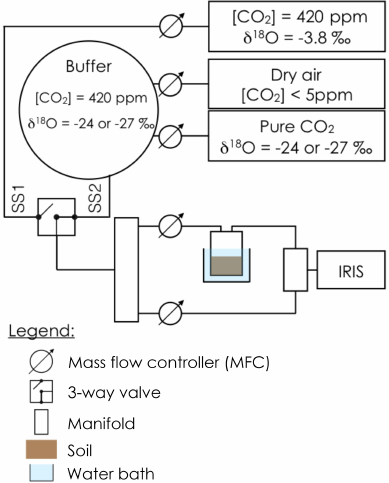
Figure 1. Schematic of the experimental setup used to estimate si- multaneously the CO 2 –H 2 O isotope exchange rate ( k iso ) in a soil microcosm and the oxygen isotopic composition of the soil water pool with which the CO 2 equilibrates ( δ sw-eq ) . The soil microcosm consists of 280–300g of dry soil previously re-humidified to 25% of the water holding capacity using mineral water containing differ- ent amounts of exogenous CA powder. The soil column is thermally regulated using a 6.5L water bath and the air entering the chamber is a mixture of CO 2 in dry air whose oxygen isotopic composition is alternatively enriched (steady state 1, − 3.8‰ VPDB g ) and de- pleted (steady state 2, between − 24 and − 27‰ VPDB g , depending on the